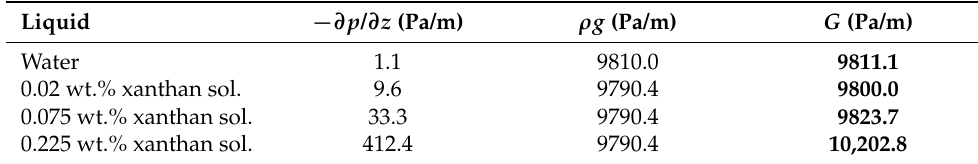
Table 3. Modified friction pressure